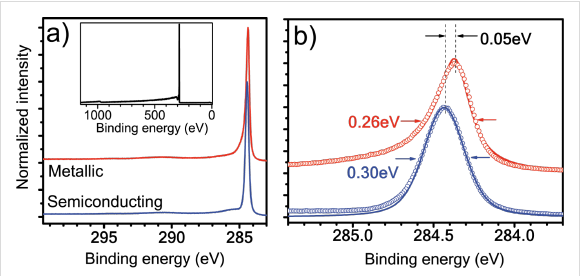
Figure 2: The photoemission response of metallicity-separated and purified single-walled carbon nanotube buckypapers. (a) C 1s photo- emission of metallic (red upper curve) and semiconducting (blue lower curve) SWCNTs measured with a 400 eV photon excitation. The inset shows a survey scan, demonstrating the purity of the samples. (b) An expanded view of the C 1s line. The response of the metallic sample has been fitted with a Doniach–Šunji ć and the semiconducting with a Voigtian lineshape. Reproduced with permission from [37], copyright 2009 The American Physical